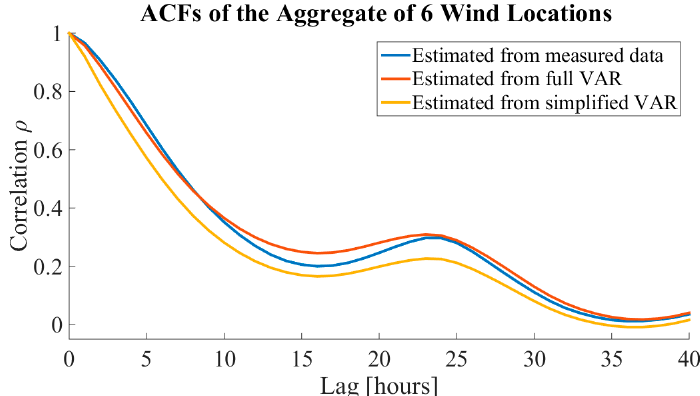
Figure 4. The ACFs estimated from the aggregated measurement data and from the aggregated simulated data from the two models for the six wind speed test locations. The presented simulation results are averages of the 100 MC runs.